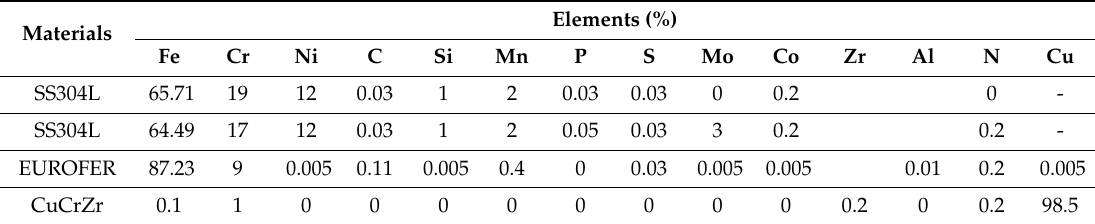
Table 2. Typical composition of the main metals of current and future use (EUROFER).